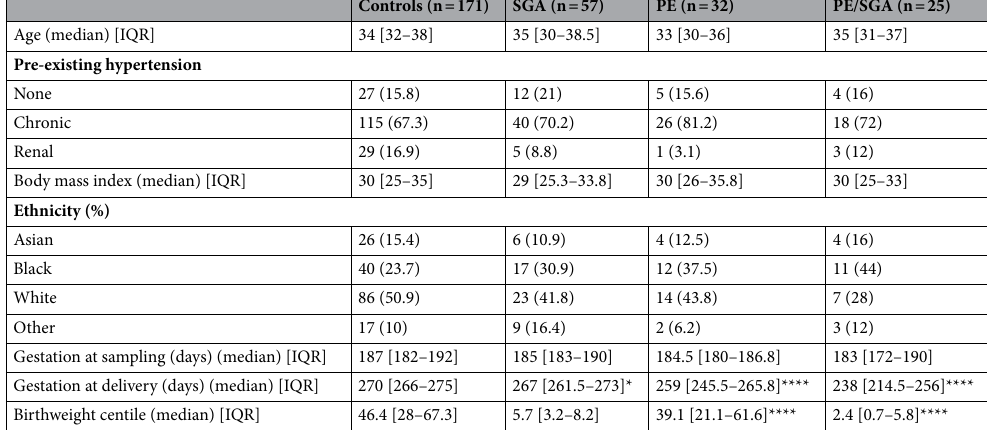
Table 2. Maternal characteristics and pregnancy outcomes for Cohort 2, the Manchester Antenatal Vascular Service (MAViS clinic). Data presented as median [25th–75th percentile], and as number (%) if categorical. Small-for-gestational-age defined as birthweight < 10th centile.*p < 0.05, ****p < 0.0001 compared to control. Ethnicity missing for n = 2 controls, n = 2